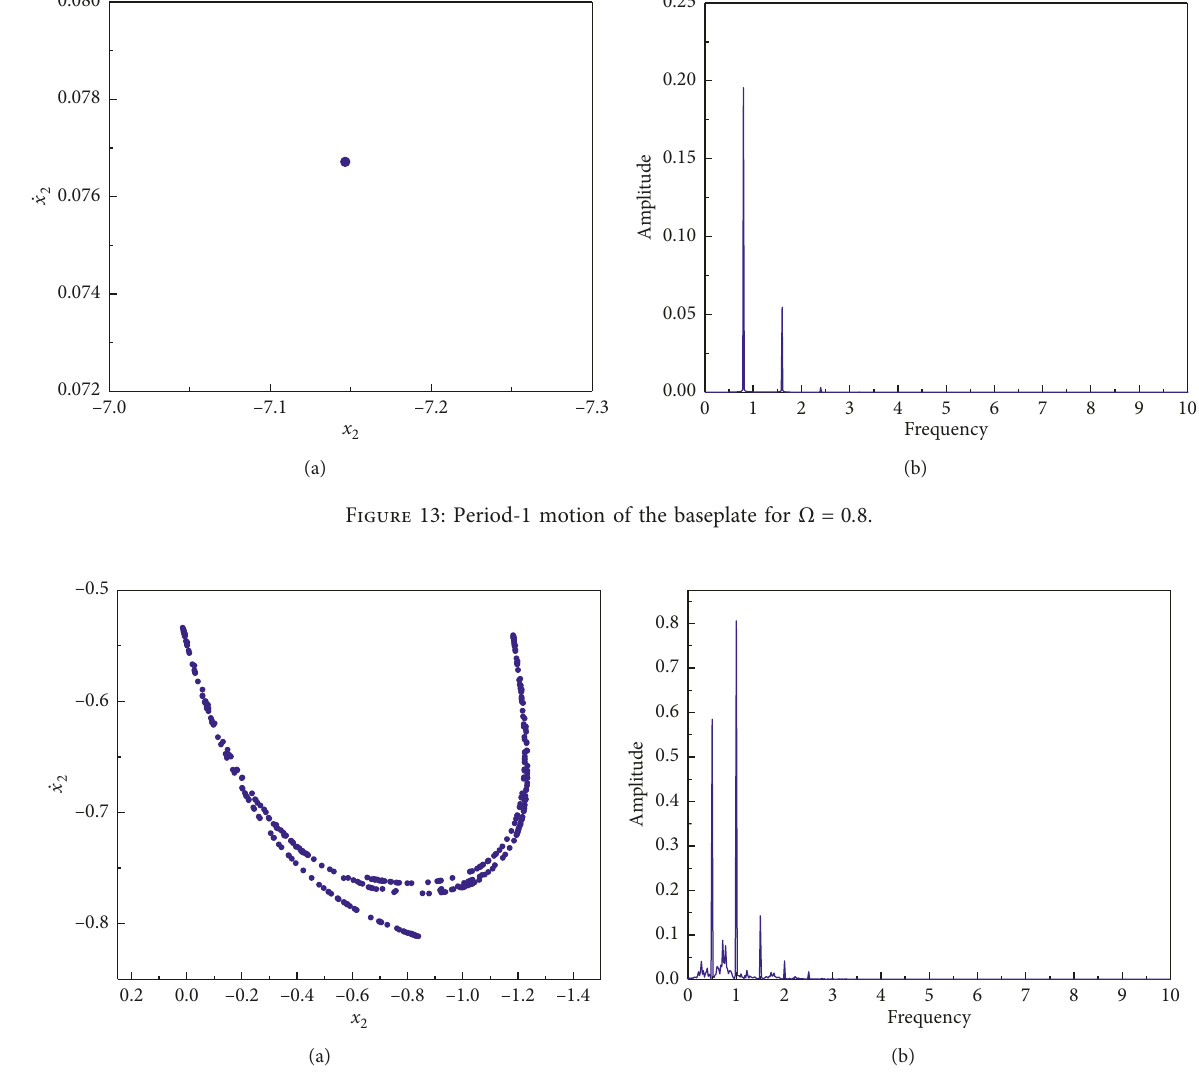
Figure 14: Chaotic motion of the baseplate for Ω � 1 . 001.